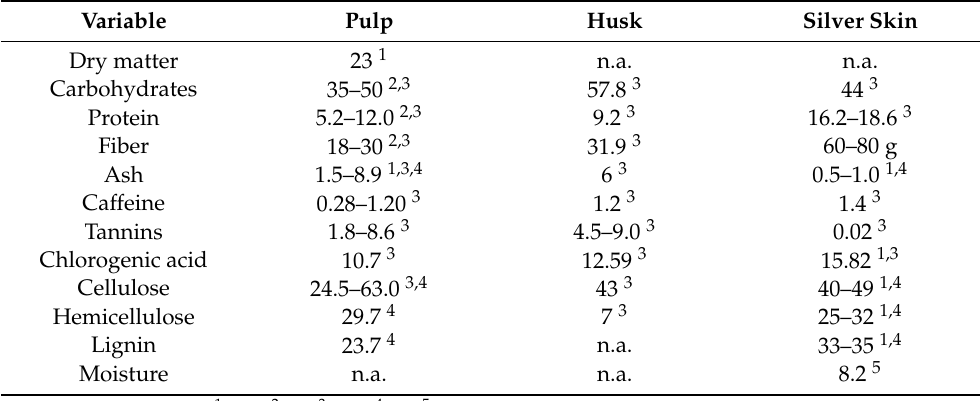
Table 1. Composition of different fractions of coffee grain (in